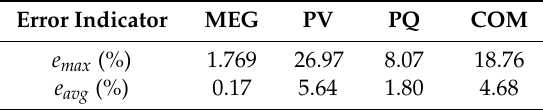
Table 4. Equivalent errors of four models in Scenario